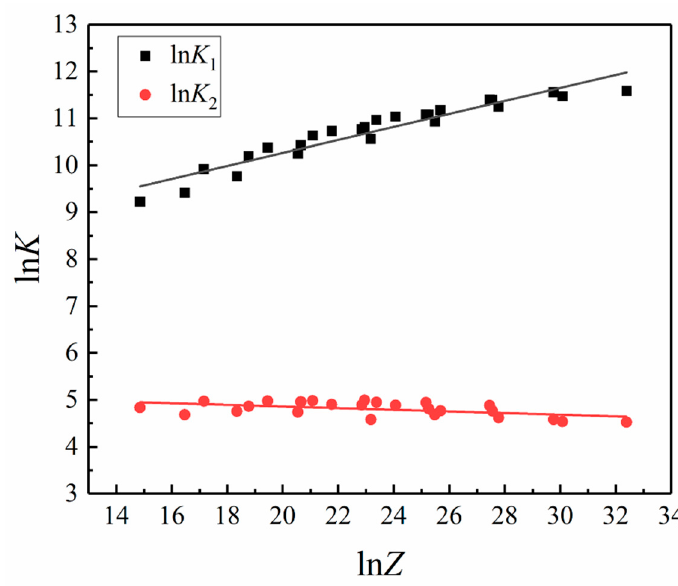
K and ln Z . Figure 4. Linear relationships between ln K i and ln Z i